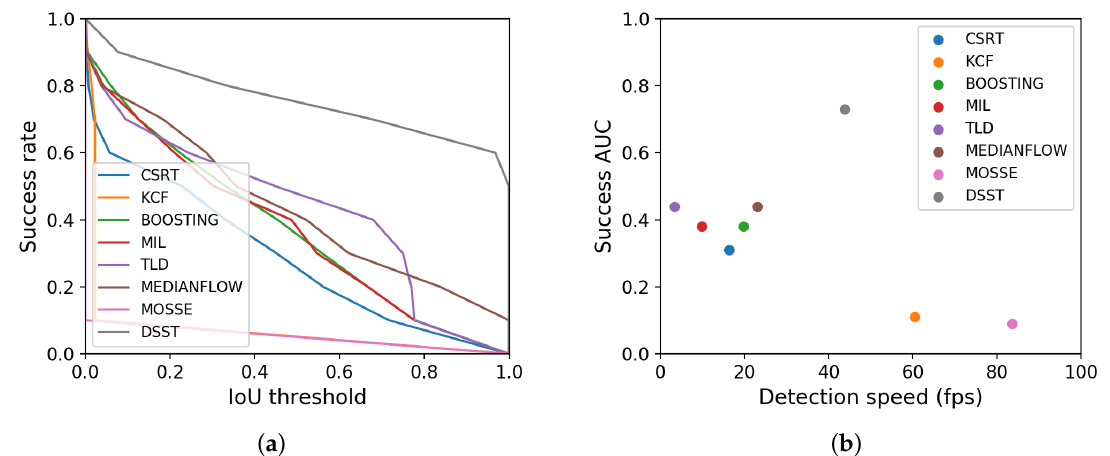
Figure 3. Tracking benchmark for CSRT (Channel and Spatial Reliability Tracker) [12], KCF (Kernelized